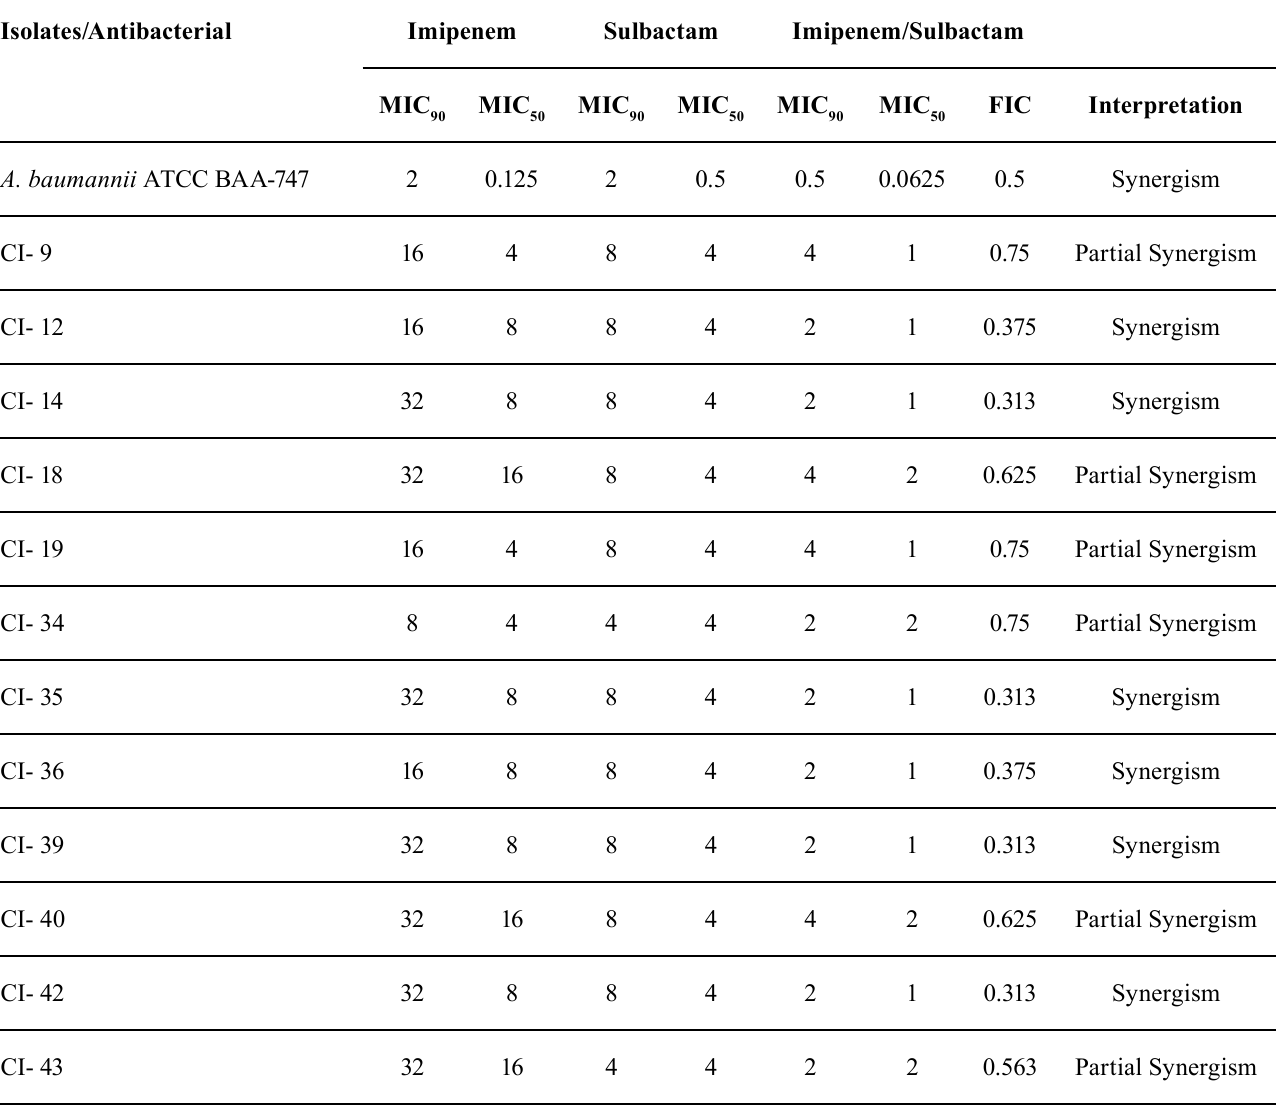
TABLE II – MIC (μg/mL) and FIC values of imipenem and sulbactam alone and in combination against carbapenemases producing A. baumannii